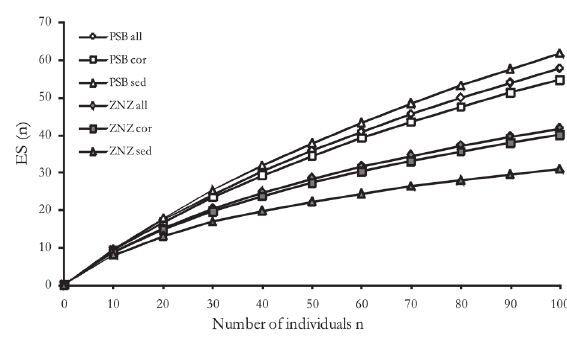
Fig . 3. – rarefaction curves for pooled samples per microhabitat (sediment: sed, cor: coral) and for the combined community in the two microhabitats (all), in the cold-water coral degradation zone at the Porcupine seabight (PsB) and the tropical lagoon on Zanzibar (ZnZ). es (n), expected number of species.